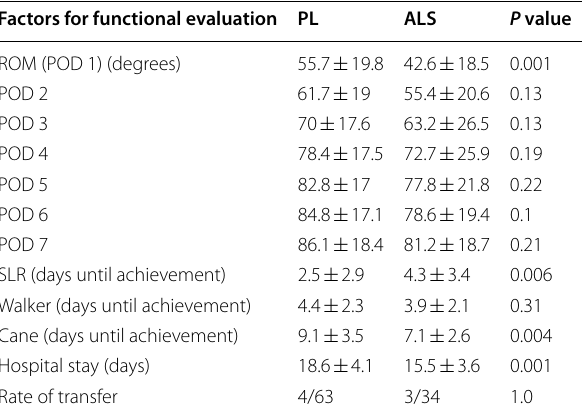
Table 5 Postoperative functional evaluation of patients in the PL and ALS groups